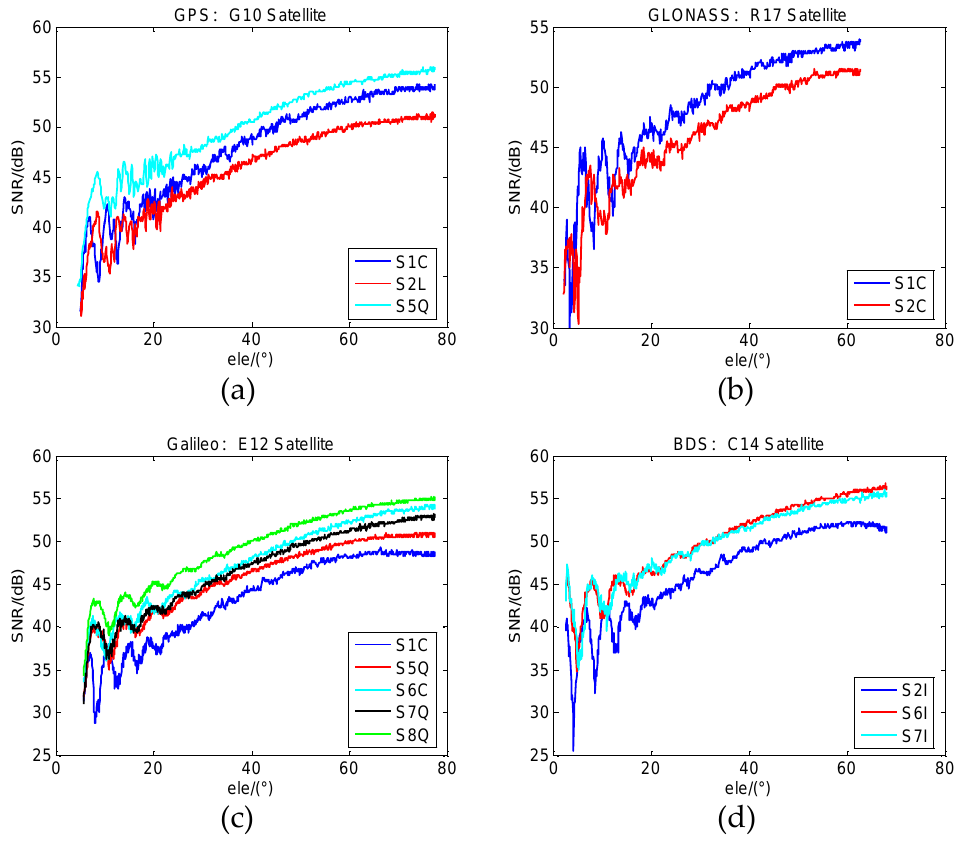
Figure 7. Multi-GNSS and multi-frequency SNR sequences: ( a ) DOY 024: GPS SNR sequence; ( b ) DOY 024: GLONASS SNR sequence; ( c ) DOY 024: Galileo SNR sequence; ( d ) DOY 024: BDS SNR sequence.